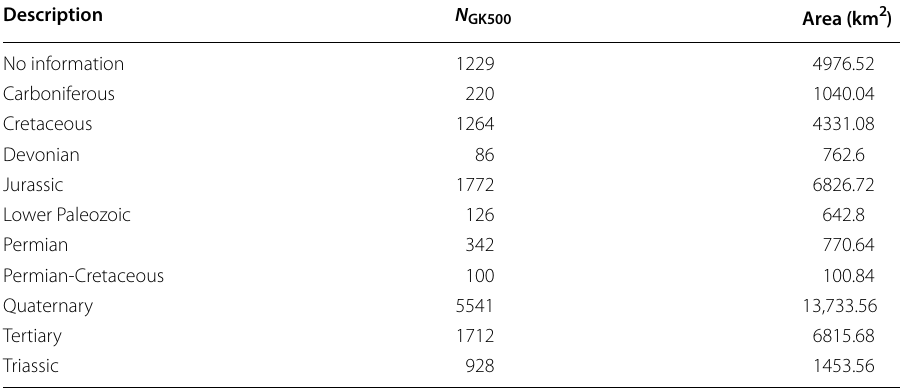
Table 5 Geological period [PERIOD] categories in GK500